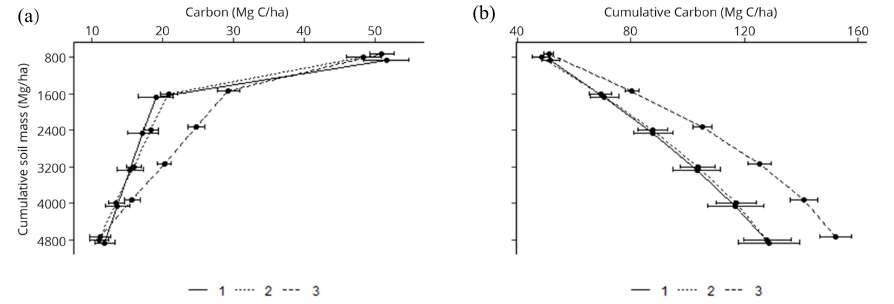
Figure 4. ( a ) Soil C stock (Mg C/ha) in each equivalent soil mass (ESM) increment of 800 Mg/ha and ( b ) cumulative soil C stock (Mg C/ha) for each plots. Points are plot means and error bars show ± one standard error.